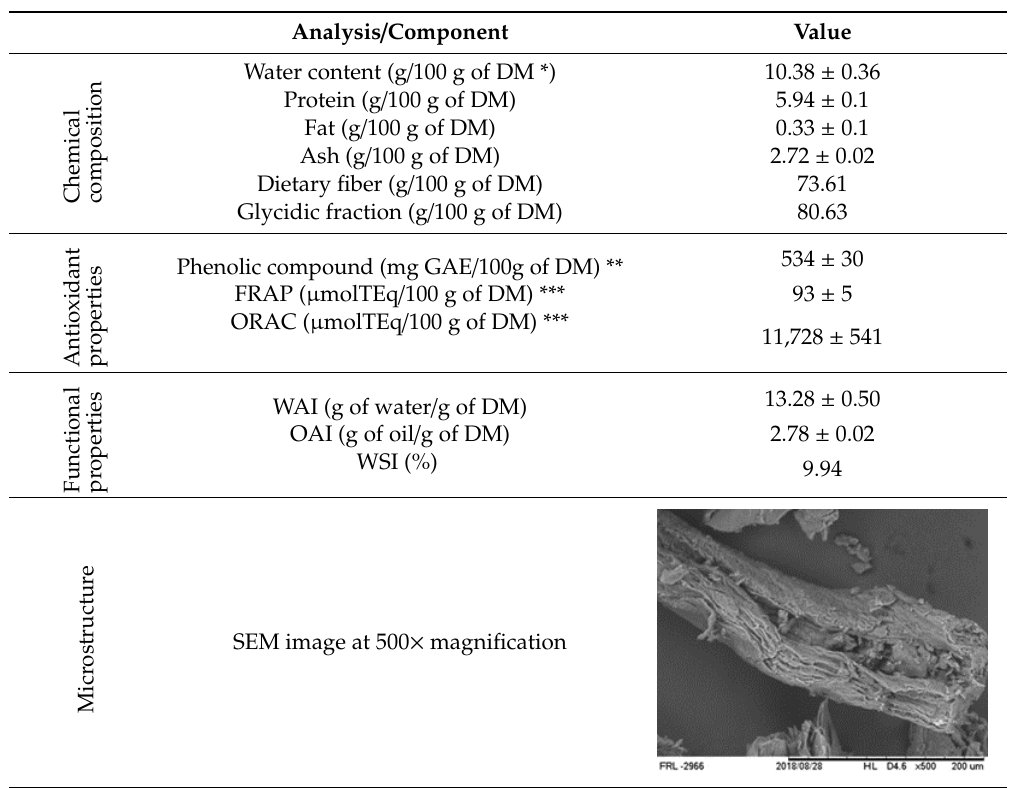
Table 2. Results from the di ff erent analysis of the orange by-product flour produced.